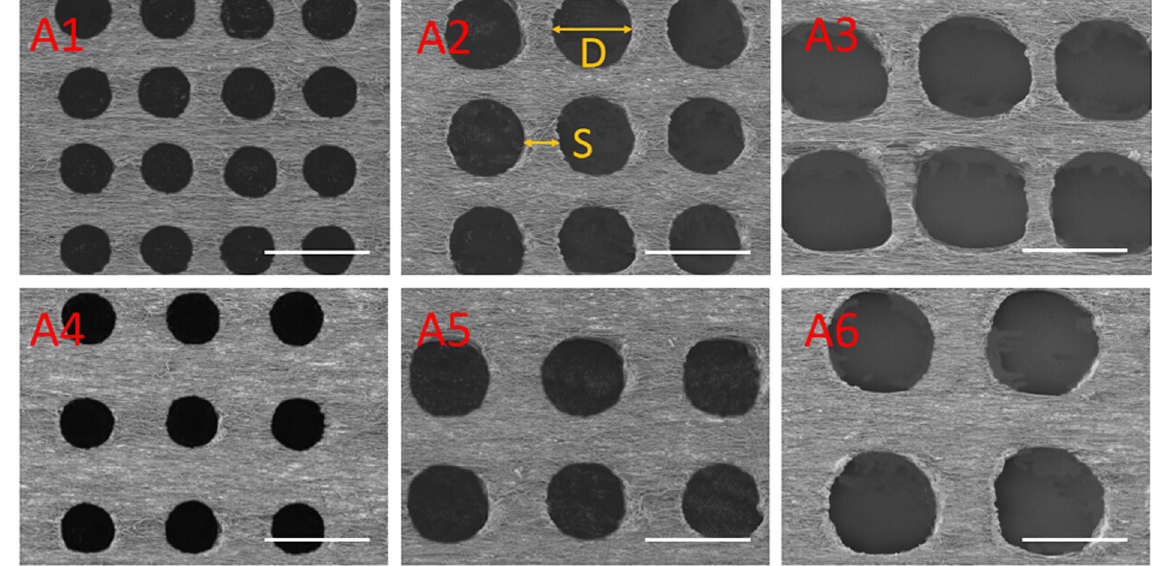
Figure 3. SEM images of laser-perforated, aligned PLGA scaffolds with different hole sizes (D) and spacings (S); A1-A6 are the samples shown in Table 1. The scale bar is 200 μ m.